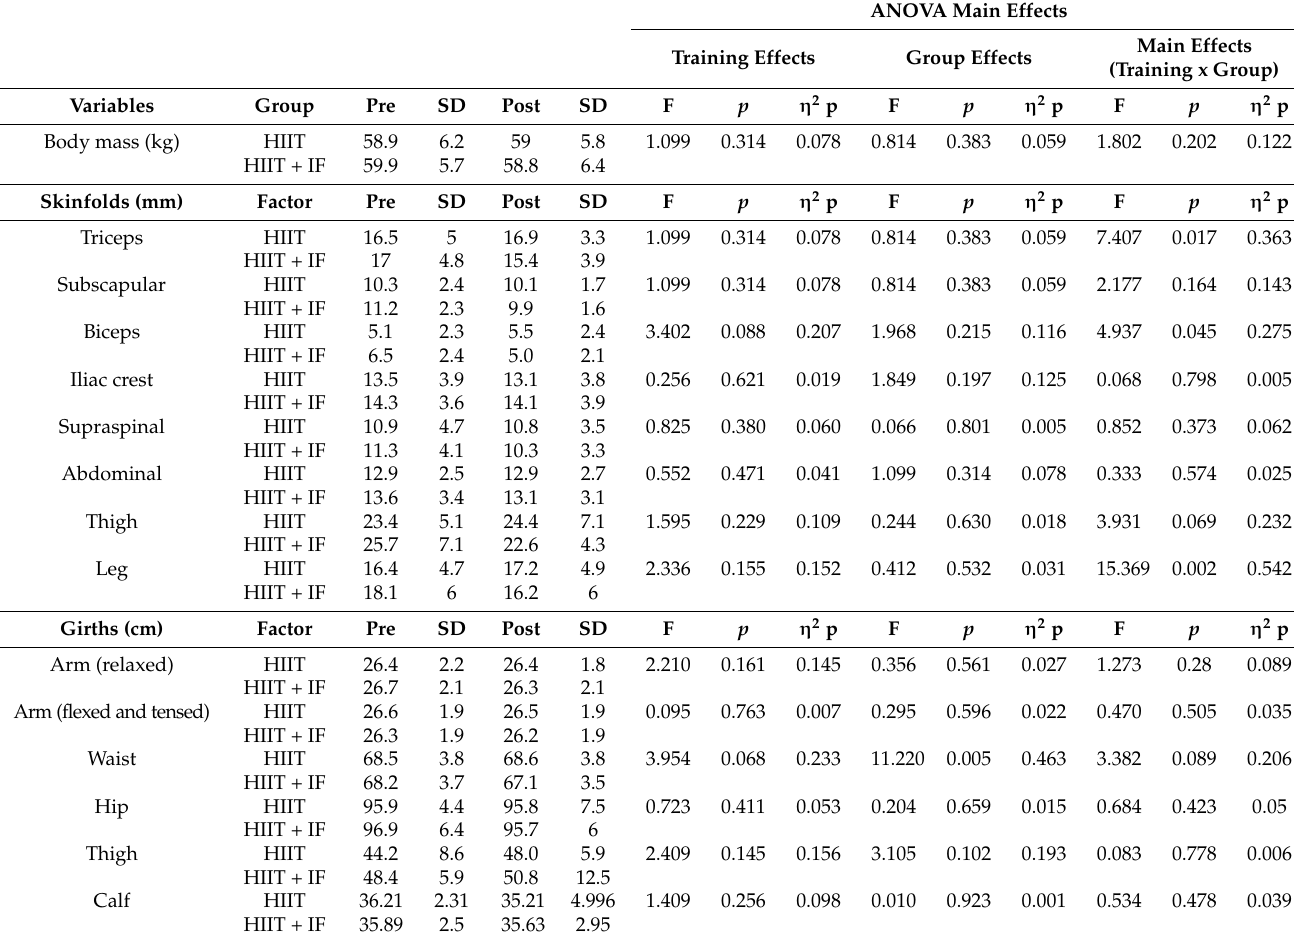
Table 1. Changes in anthropometric variables.